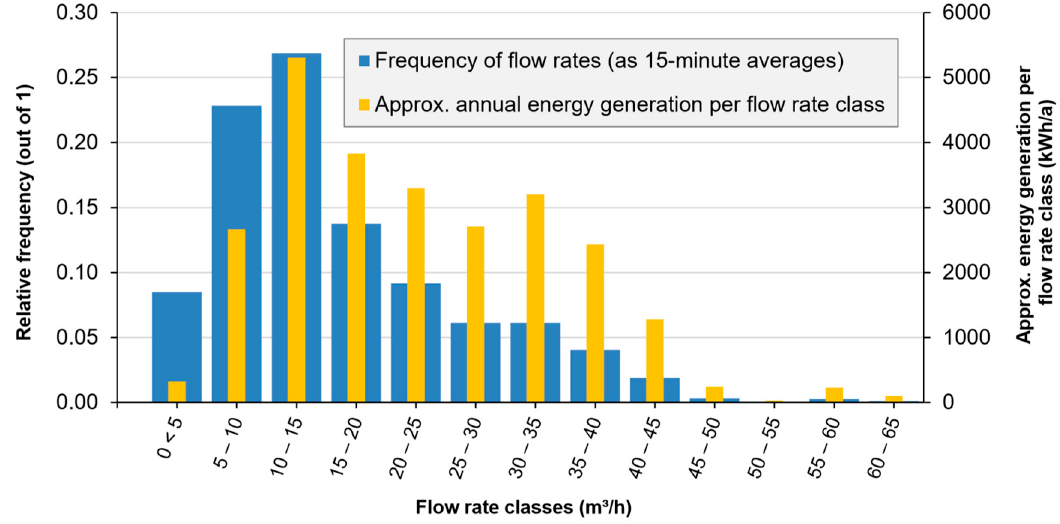
Figure 10. Frequency distribution of outflow rates and corresponding estimated annual electrical energy generation per flow rate class, at 15-min intervals for BPT Rützengrün.